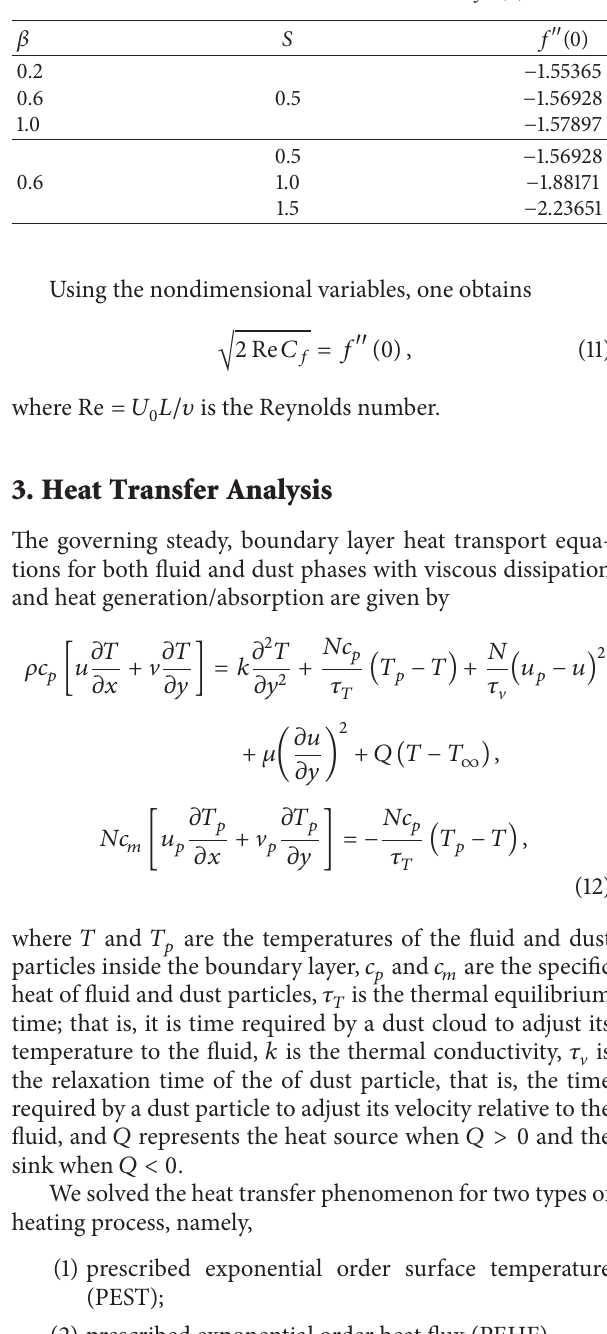
Table 3: Values of skin friction coefficient 𝑓 󸀠󸀠 (0)